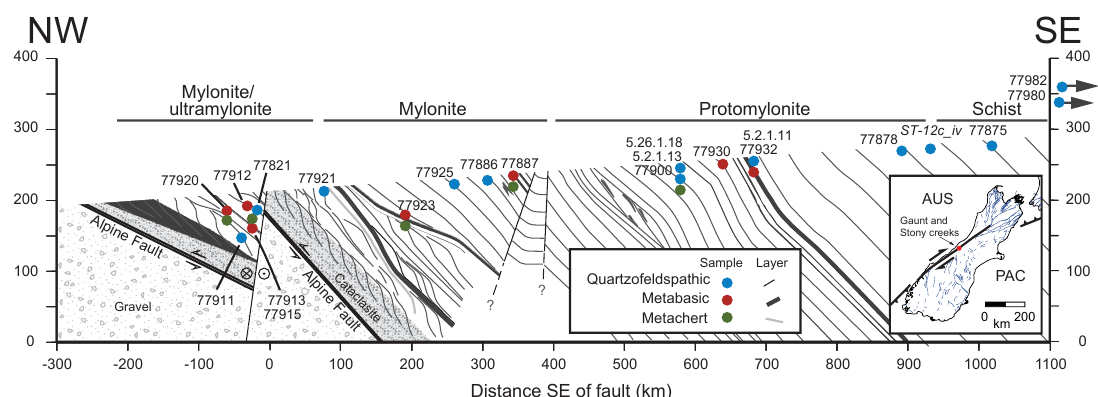
Figure 1. Schematic cross section of Gaunt Creek after Toy et al. (2008) showing approximate sample locations. Inset shows the South Island of New Zealand and the locations of Gaunt and Stony creeks. The position of the Stony Creek sample (ST-12c_iv) is projected into an approximate position based on its structural distance from the Alpine